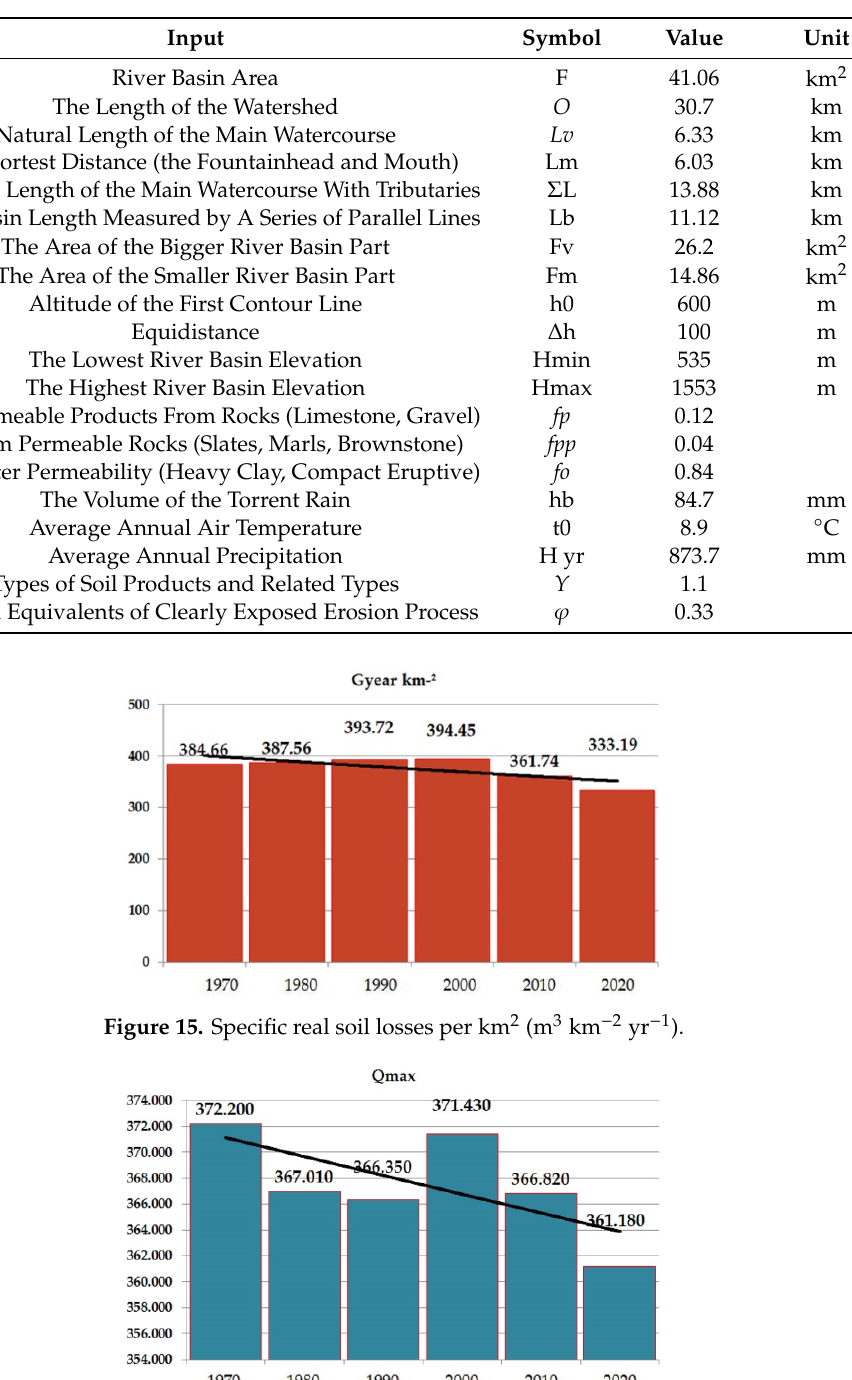
Table 5. The IntErO report of Inputs for the Miocki Potok river basin.